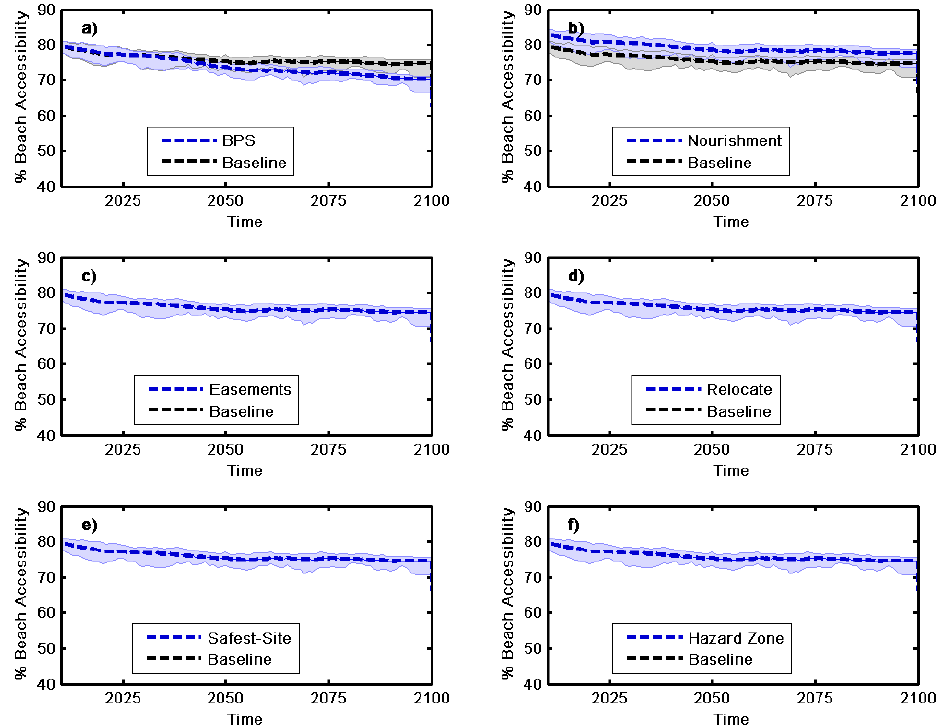
Figure 9. Beach accessibility through time under each of the six policy drivers (panels a – f ). Dashed lines indicate the decadal mean of all simulations. Bounds represent the minimum and maximum decadal means.